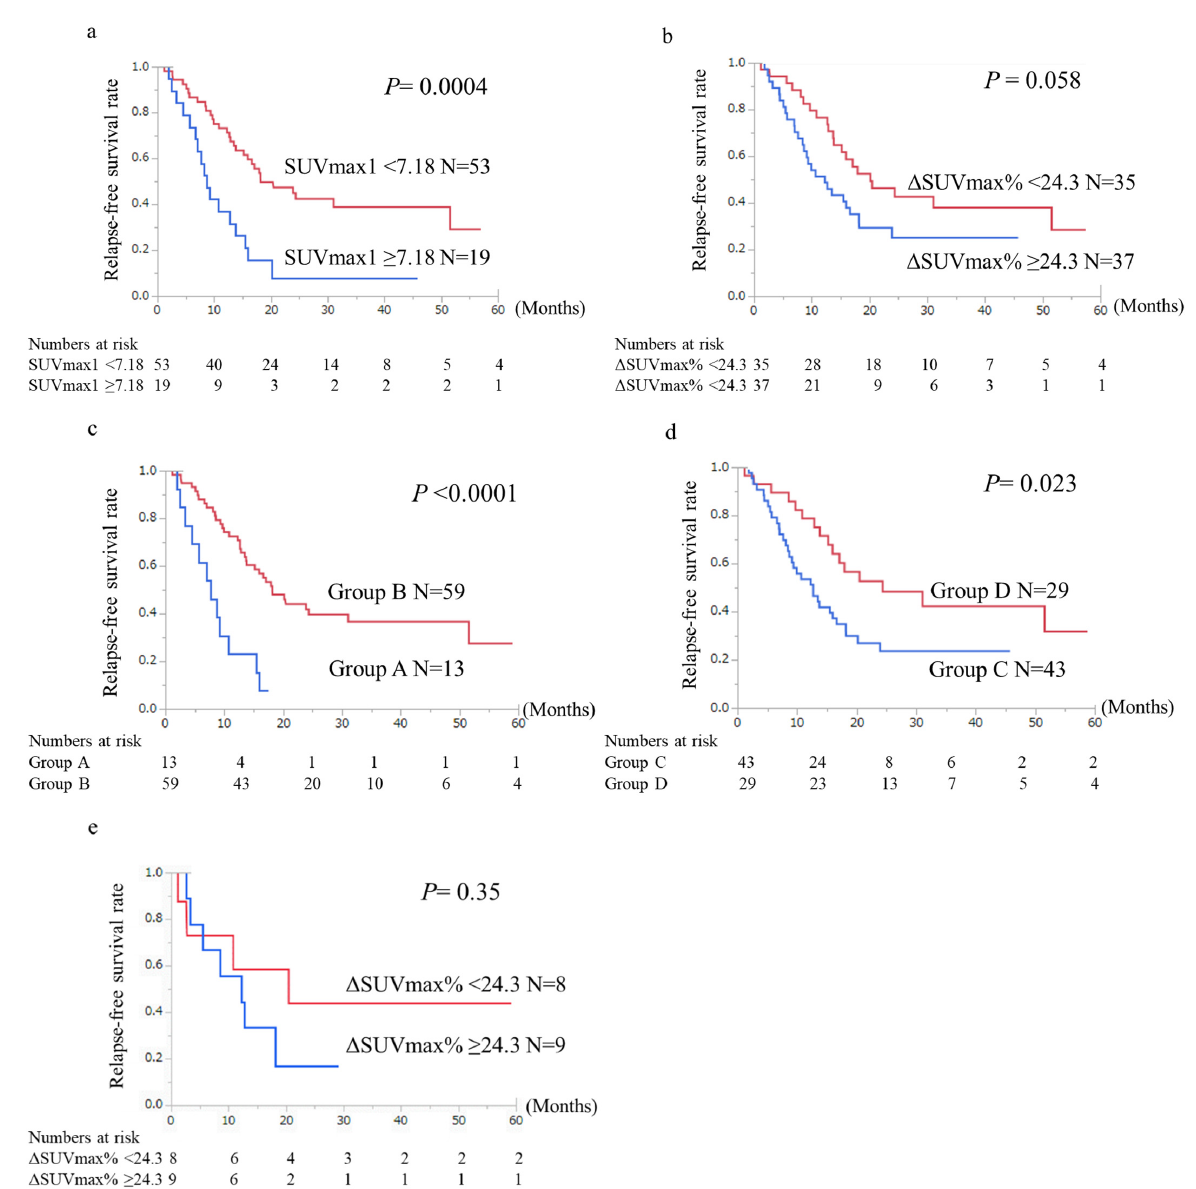
Figure 4. Comparison of relapse-free survival (RFS) curves between the patient groups of ( a ) high and low SUVmax1 values, ( b ) high and low ∆ SUVmax%, ( c ) Group A, high SUVmax1 and high ∆ SUVmax%, and Group B, and others, and ( d ) with Group C, high SUVmax1 and/or high ∆ SUVmax%, and Group D, and others. ( e ) High and low ∆ SUVmax% in diabetes mellitus patients. The group of high SUVmax1, Group A and Group C represented statistically unfavorable outcomes compared with the group of low SUVmax1 ( a : P = 0.0004), Group B ( c : P < 0.0001) and Group D ( d : P = 0.023). On the other hand, ∆ SUVmax% ( b ) and ∆ SUVmax% in diabetes mellitus patients ( e ) were not correlated with RFS of the